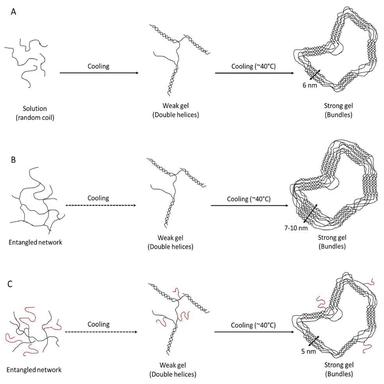
Scheme illustrating the proposed nanostructure of different agar-based hydrogels in their initial "solution" state and after being subjected to cooling ramps. (A) Commercial agar, (B) HW and HW-US agar-based extracts and (C) NaOH+HW and NaOH+HW-US agar-based extracts.